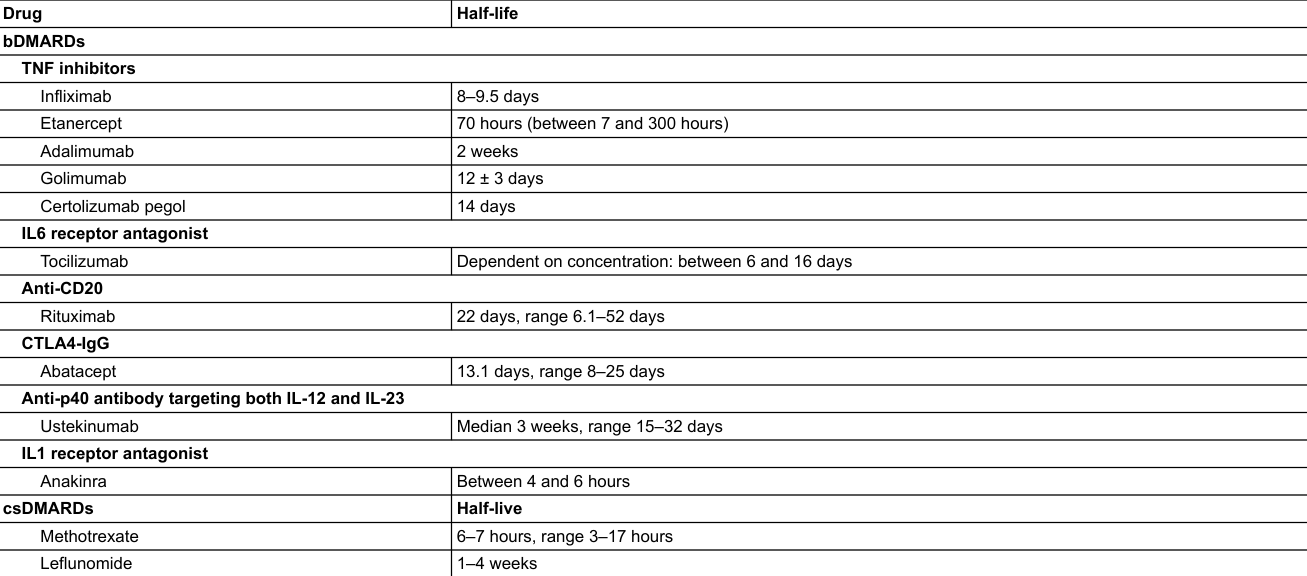
Table 3: Half-lives of disease-modifying antirheumatic drugs.